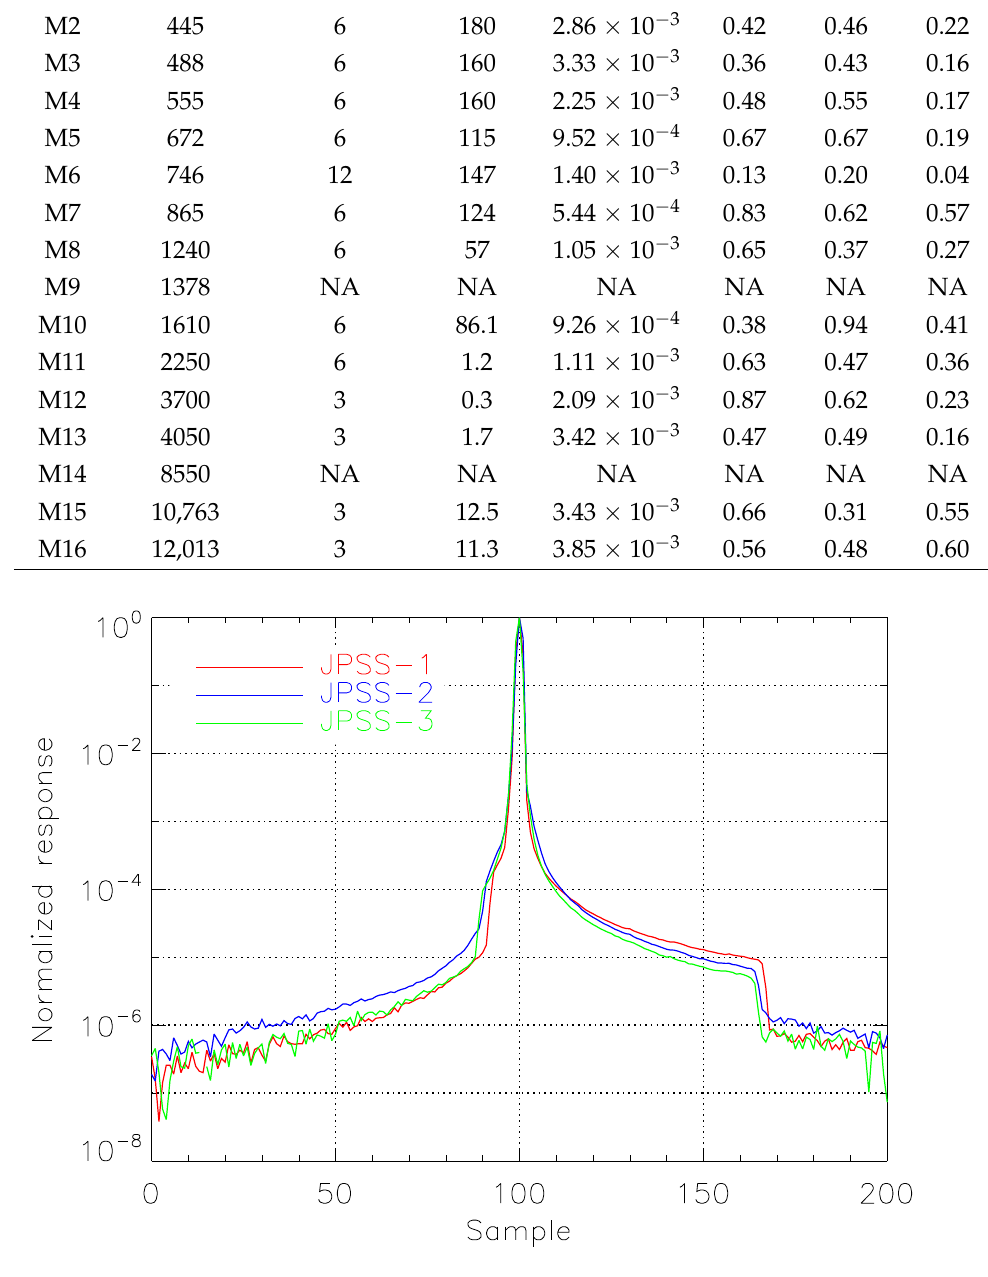
Figure 8. VIIRS NFR for band M4 plotted versus pixel when viewing a line source. JPSS-1 and JPSS-2 NFR are shown for